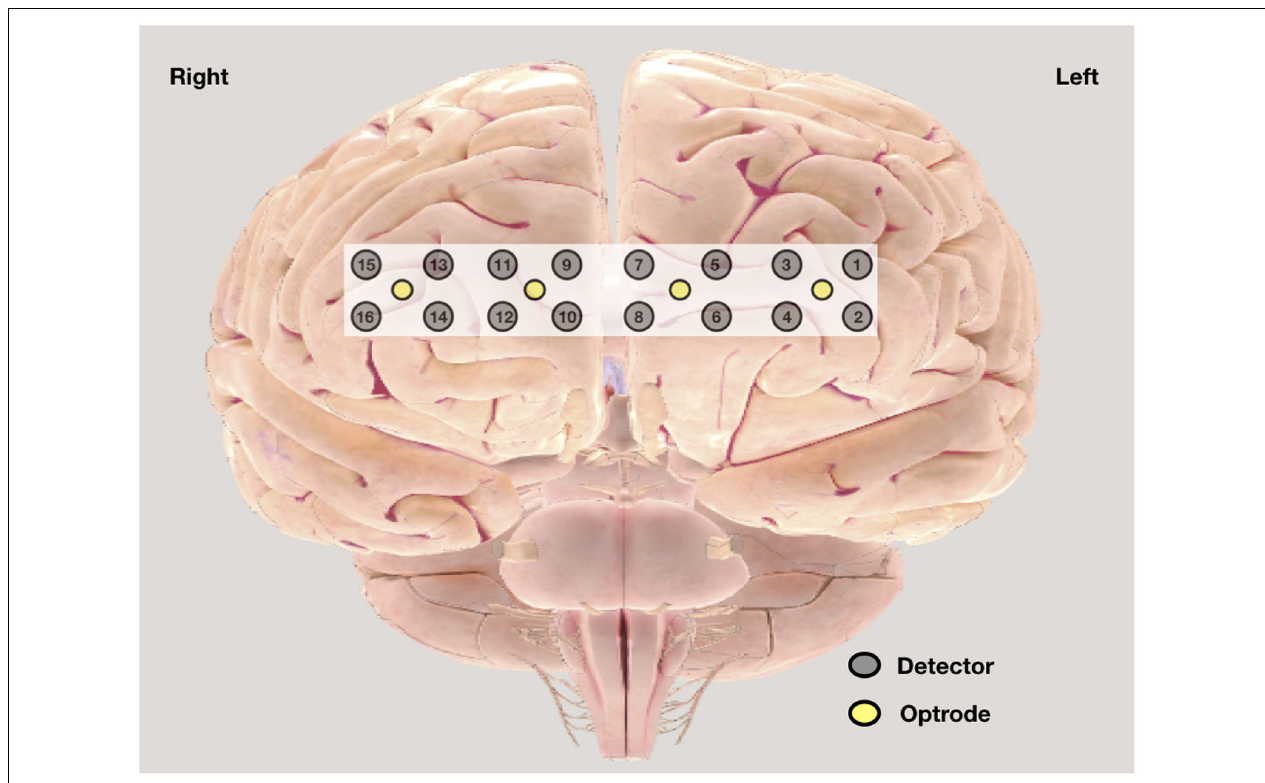
FIGURE 1 | Graphic position of optrode and detectors in functional near-infrared spectroscopy (fNIRS) band.